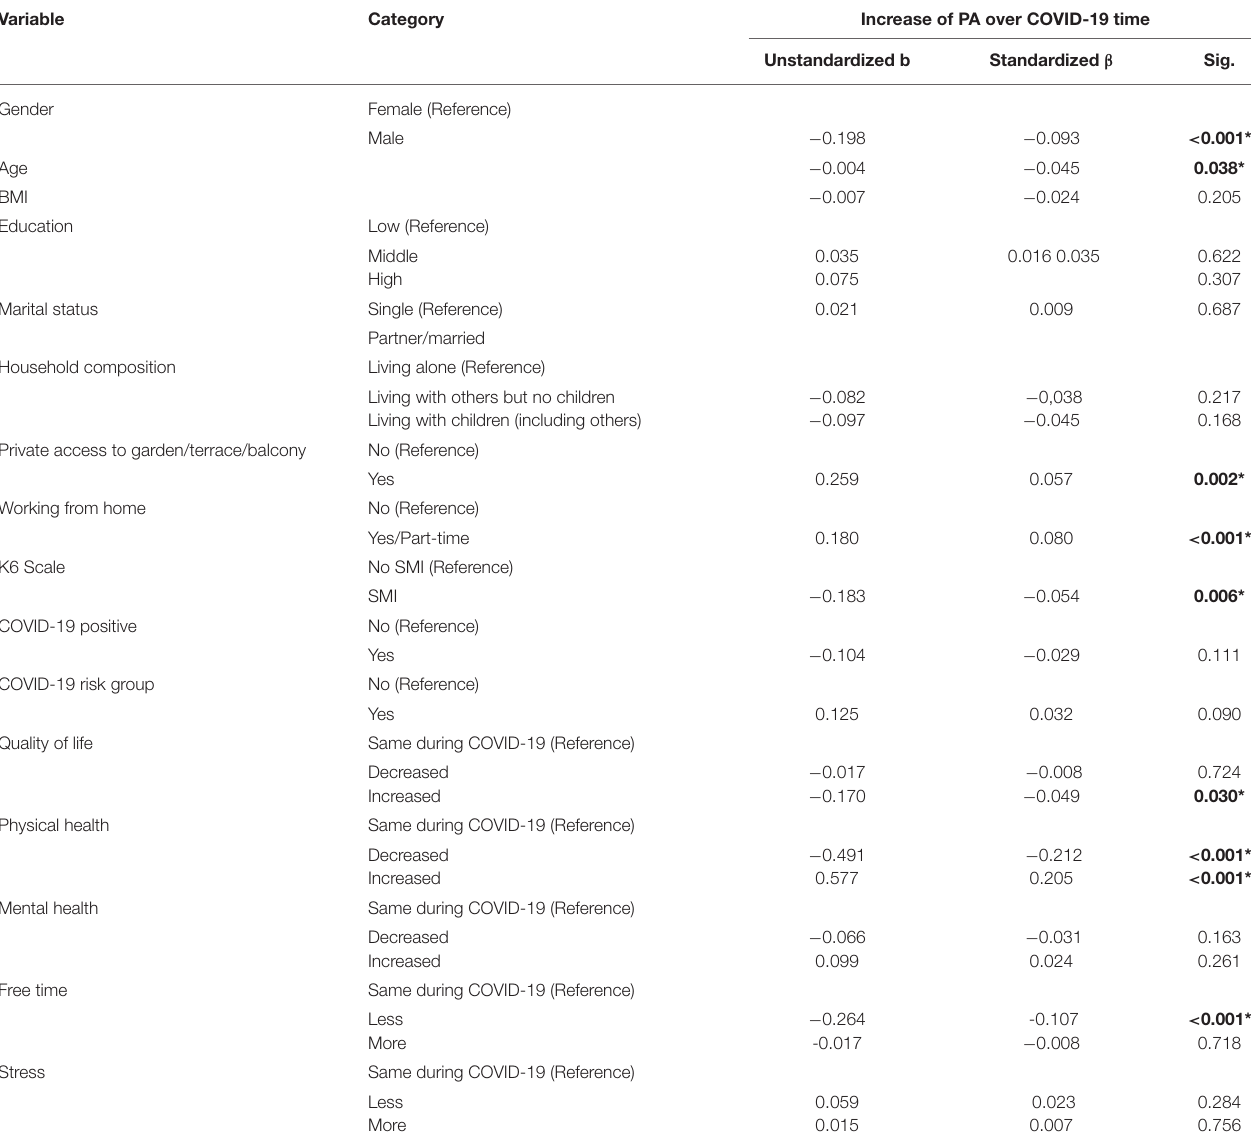
TABLE 5 | Associations between increased PA behavior and several variables.